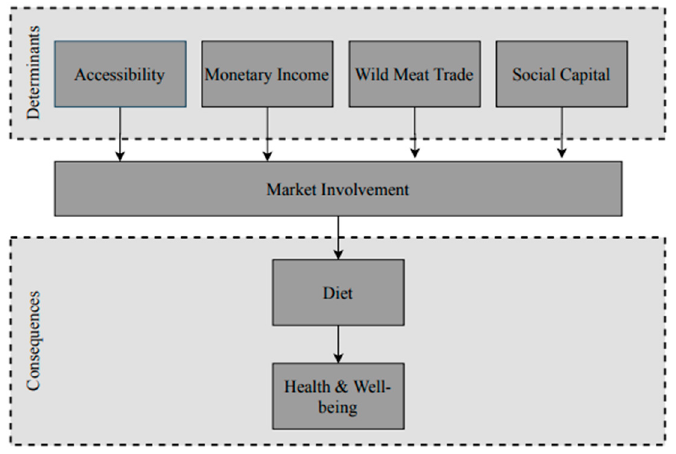
Figure 1. Scope of this article: determinants and consequences of market involvement.